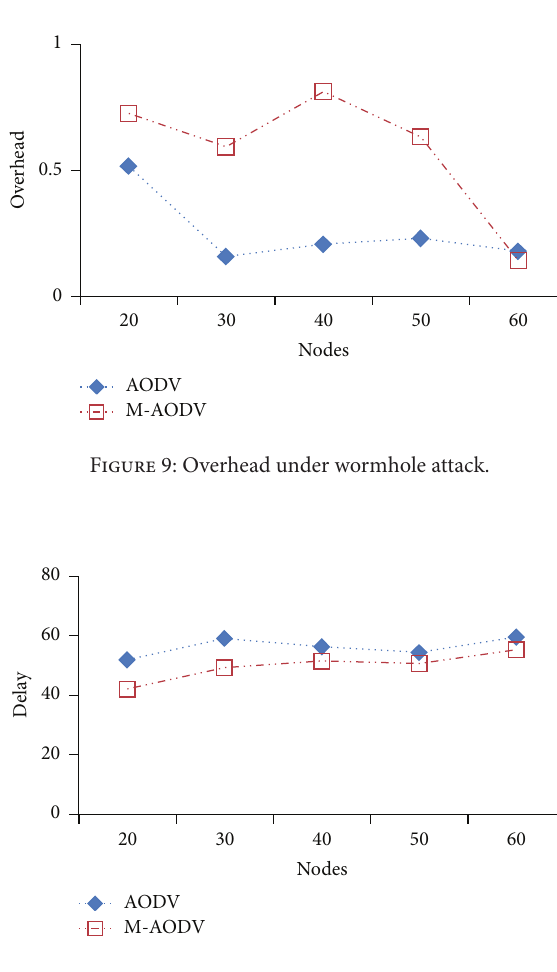
Figure 10: Delay under black hole